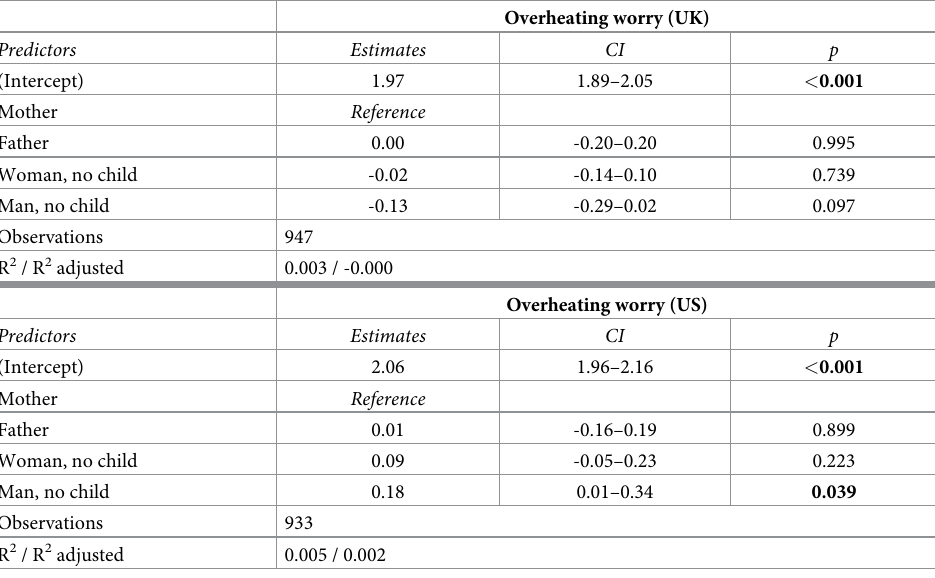
Table 1. Relating overheating worry to gender and parental status. a) Regression results UK sample (mother as ref- erence category). b) Regression results US sample (mother as reference category).